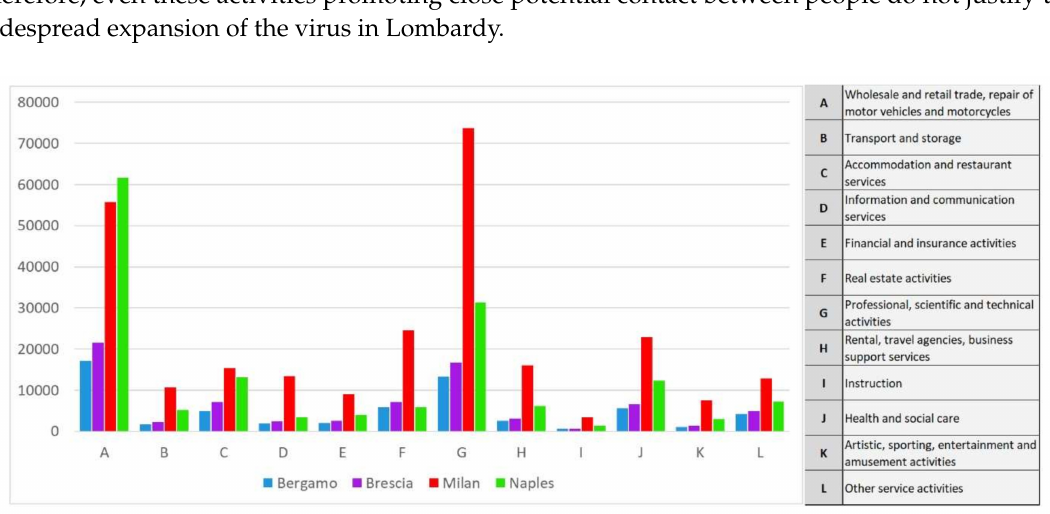
Figure 7. Number of firms operating in the tertiary sector in the four examined